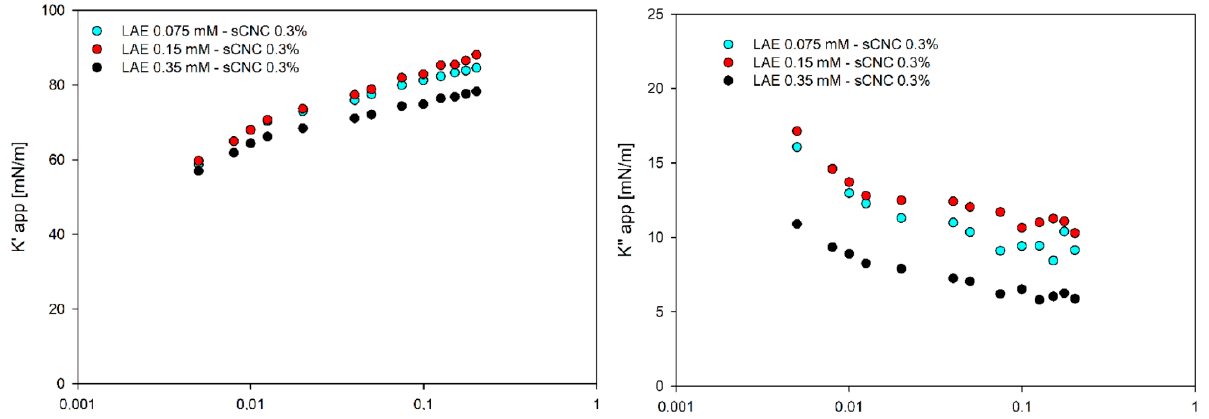
Figure 8. Apparent elastic (K’) and loss (K”) moduli for sCNC suspensions with various concentra ‐ tions of LAE (0.075 mM, 0.15 mM and 0.35 mM).